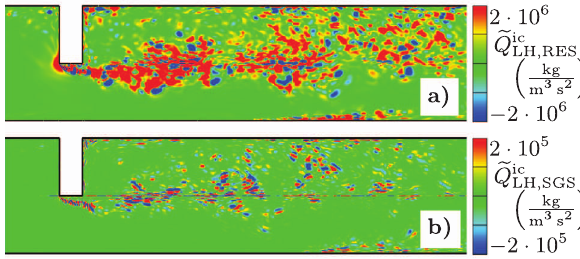
Figure 7. Contours of the (a) resolved Lighthill source term ~ Q ic and (b) the SGS contribution LH ; RES Different ranges are used for the color bars for better visualization. Figure 6. Rms of the near-wall pressure ~ p ic over z / L RP from